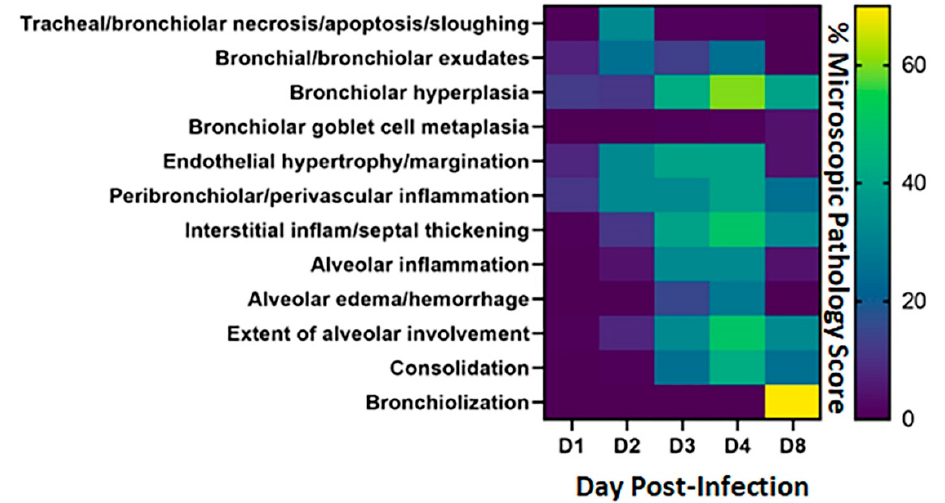
Figure 3. Heatmap of microscopic pathology of Syrian hamster lungs with SARS-CoV-2. The severity scores for each category of microscopic pathology are illustrated using a heatmap. For each of the days examined, each box represents the average score from four hamsters for scores for these categories: tracheal/bronchiolar necrosis/apoptosis/sloughing, bronchial/bronchiolar exudates, bronchiolar hyperplasia, bronchiolar goblet cell metaplasia, endothelial hypertrophy/margination, peribronchiolar/perivascular inflammation, interstitial inflammation-septal thickening, alveolar inflammation, alveolar edema/hemorrhage, extent of alveolar involvement, consolidation and bron- chiolization. Semi-quantitative scores used 0–1 = within normal limits, 2–14 = Minimal: Rare or inconspicuous lesions; 15–39 = Mild: Multifocal or small, focal, or widely separated, but conspicuous lesions; 40–79 = Moderate: Multifocal, prominent lesions; 80–99 = Marked: Extensive to coalescing lesions or areas of inflammation with some loss of structure and 100 = Severe: Diffuse lesion with effacement of normal structure. The scale to the right of the heat map reflects the scoring ranges from 0 to 70%.